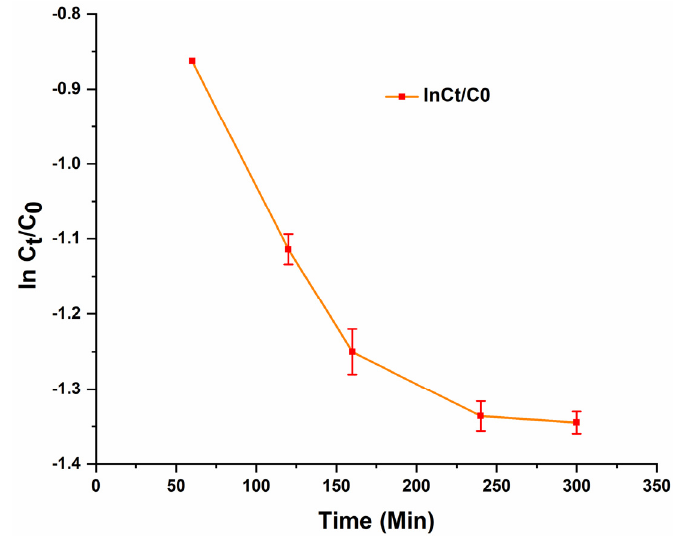
Figure 3. The plot of ln Ct/C0 vs. time.